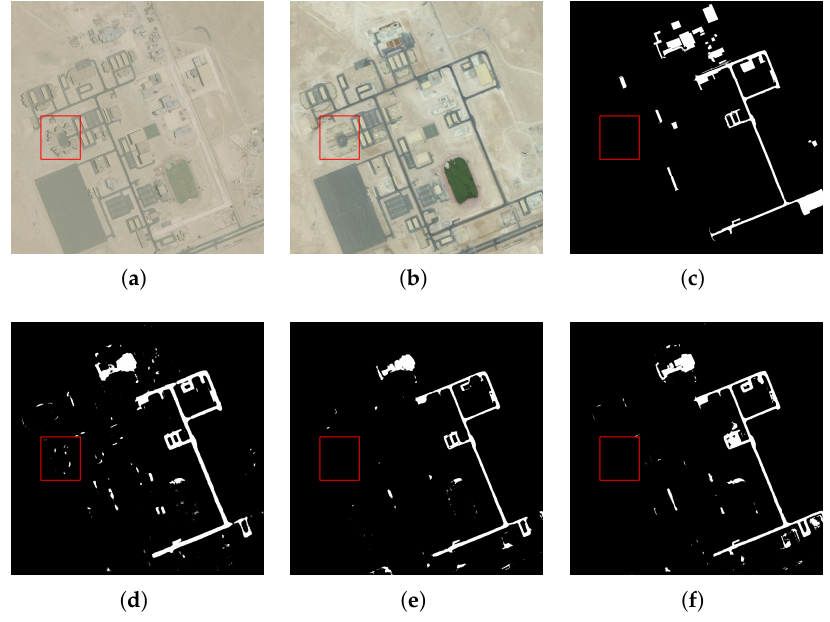
Figure 12. The results of different methods on the AUAB dataset. ( a ) Image one taken in 2009. ( b ) Image two taken in 2009. ( c ) Ground truth. ( d ) Result using FC-Siam-diff. ( e ) Result using the pseudo-siamese capsule network. ( f ) Result using the change capsule